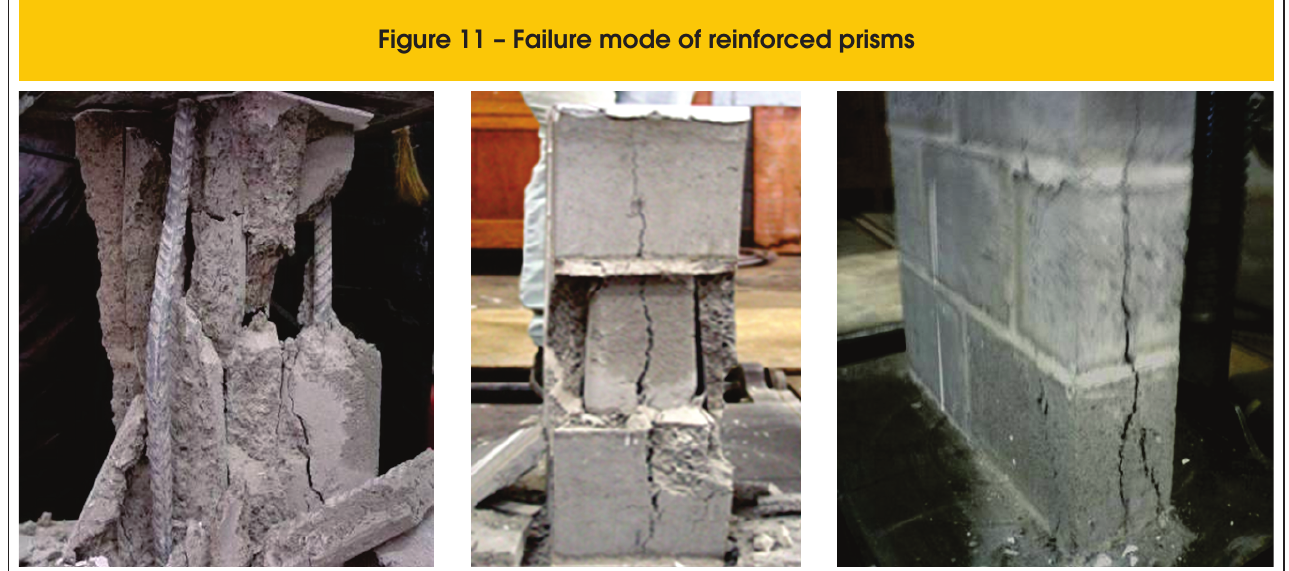
Figure 11 – Failure mode of reinforced prisms